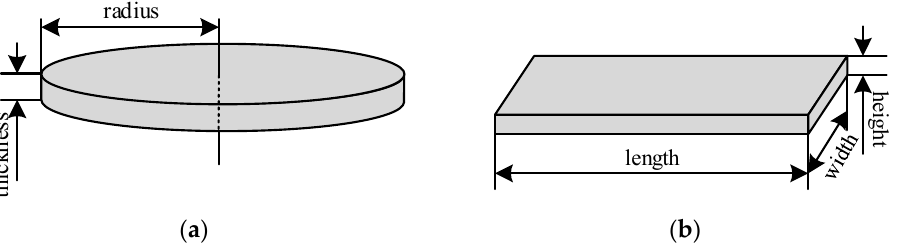
Figure 23. Structure of the shield with different shapes. ( a ) cylinder, ( b ) cuboid.